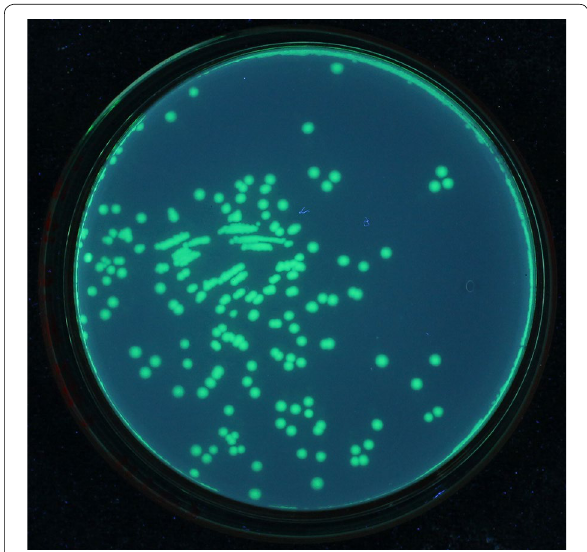
Fig. 3 Expression of EGFP cloned in pOmni in E. coli BL21. EGFP gene was cloned into pOmni by means of selection-free PCR recombina- tion cloning. All BL21 transformants showed strong green florescence under long-wave ultraviolet